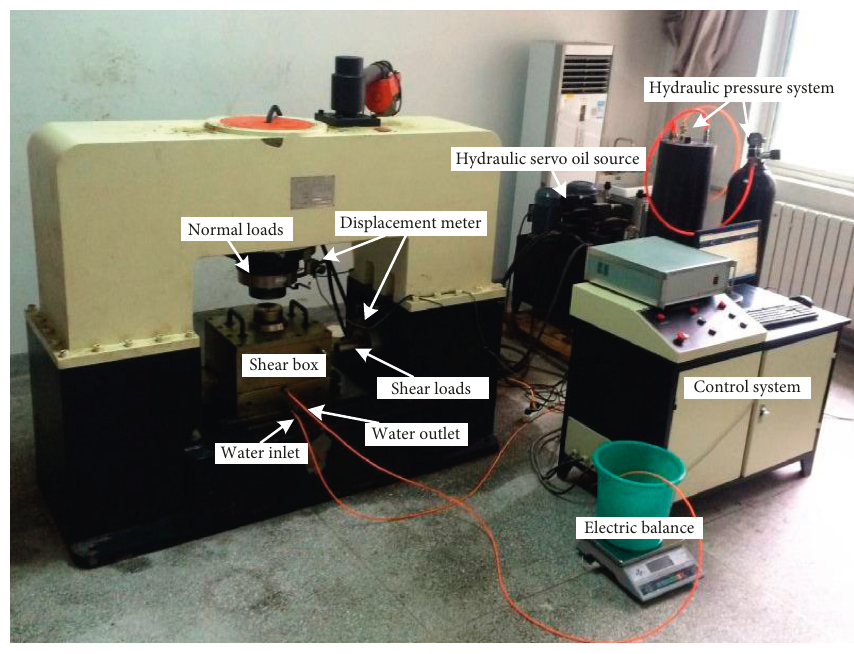
Figure 1: TJXW-600 microprocessor-control-coupled shear-seepage test system.